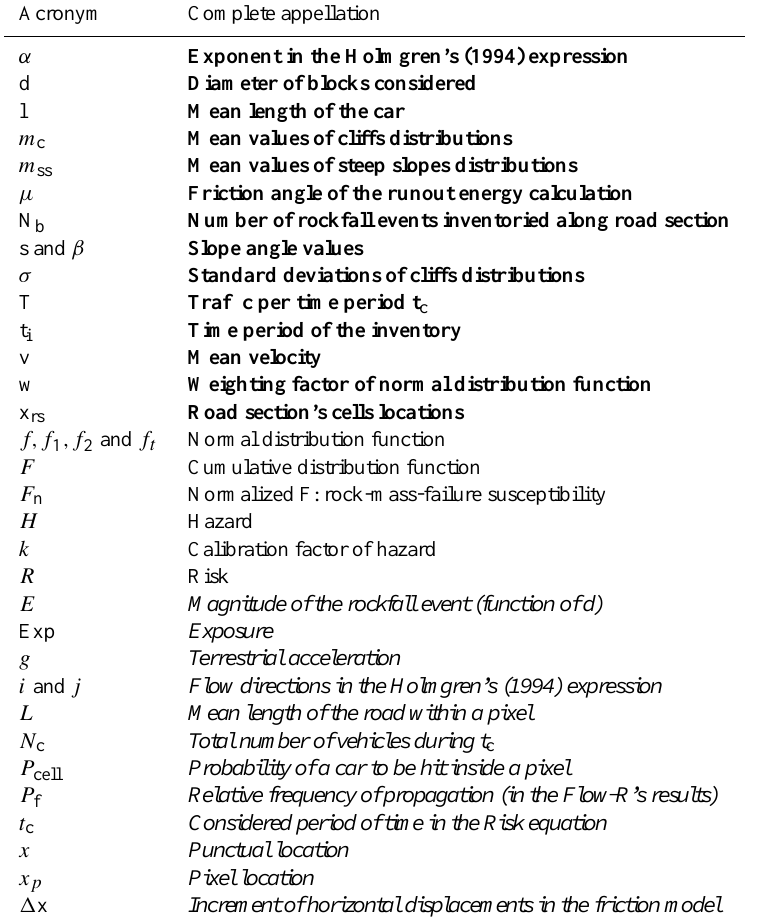
Table 1. Parameters used to assess rockfall hazard and risks along roads. Bold typo: input parameters needed to solve equations; normal typo: intermediary or final results solved during the assessment; italic typo: useless parameters because deleted during the equations’